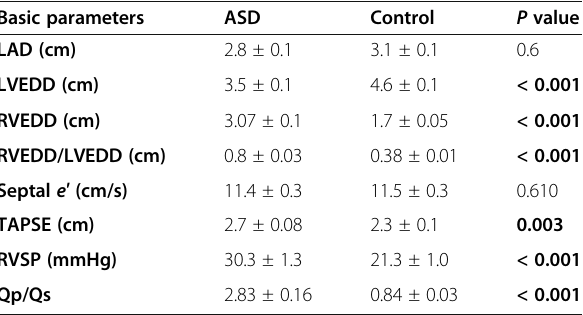
Table 2 Baseline standard transthoracic echocardiographic measures of ASD versus control groups Basic